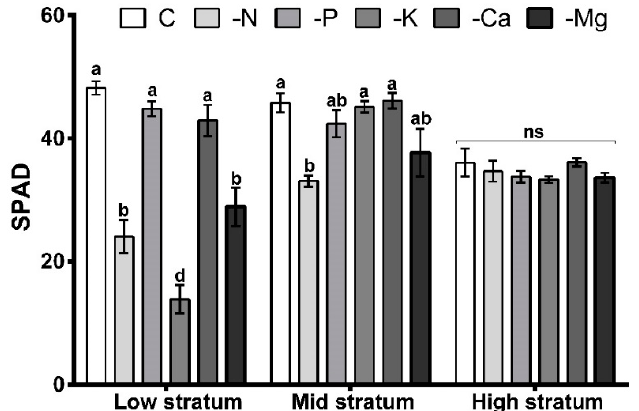
Figure 3. Relative content of chlorophyll, expressed in SPAD units in the low, medium, and high strata of fig tree plants. Di ff erent letters between the columns for each stratum indicate significant di ff erence (Tukey, p < 0.05). ns, not significant. The lines on the bars indicate the standard error of the mean. n = 4.